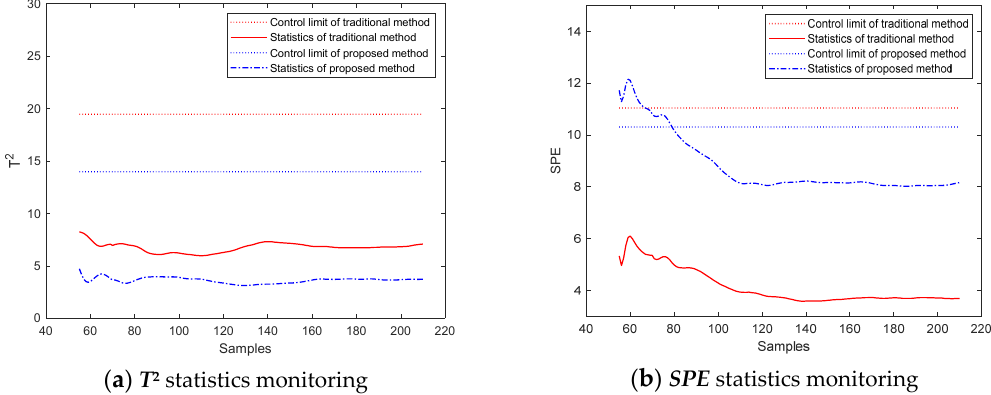
Figure 9. Single-mode online monitoring of packing-holding phase of mode 1.